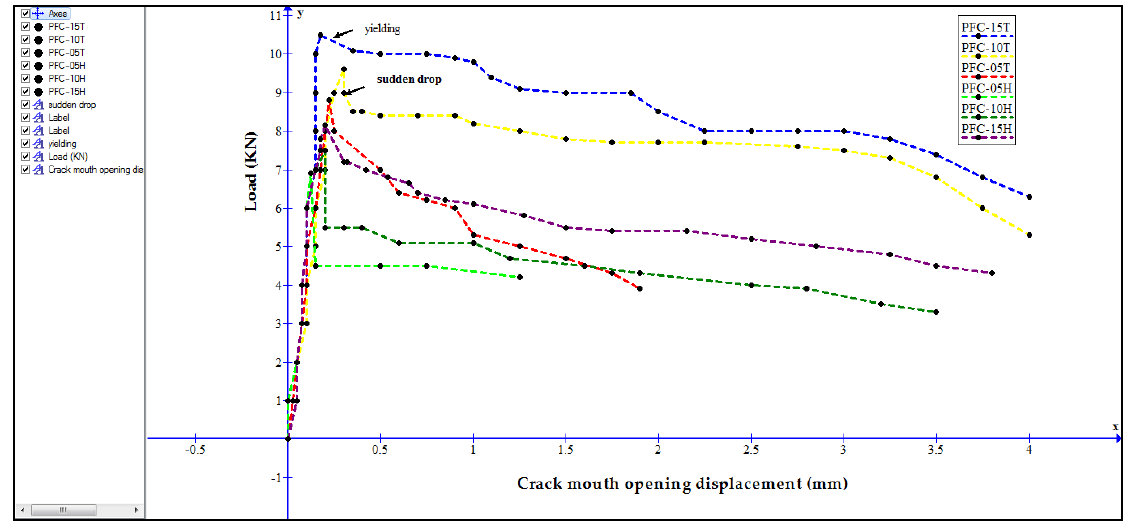
Figure 13. Load-CMOD curves for various plastic fiber incorporated concrete